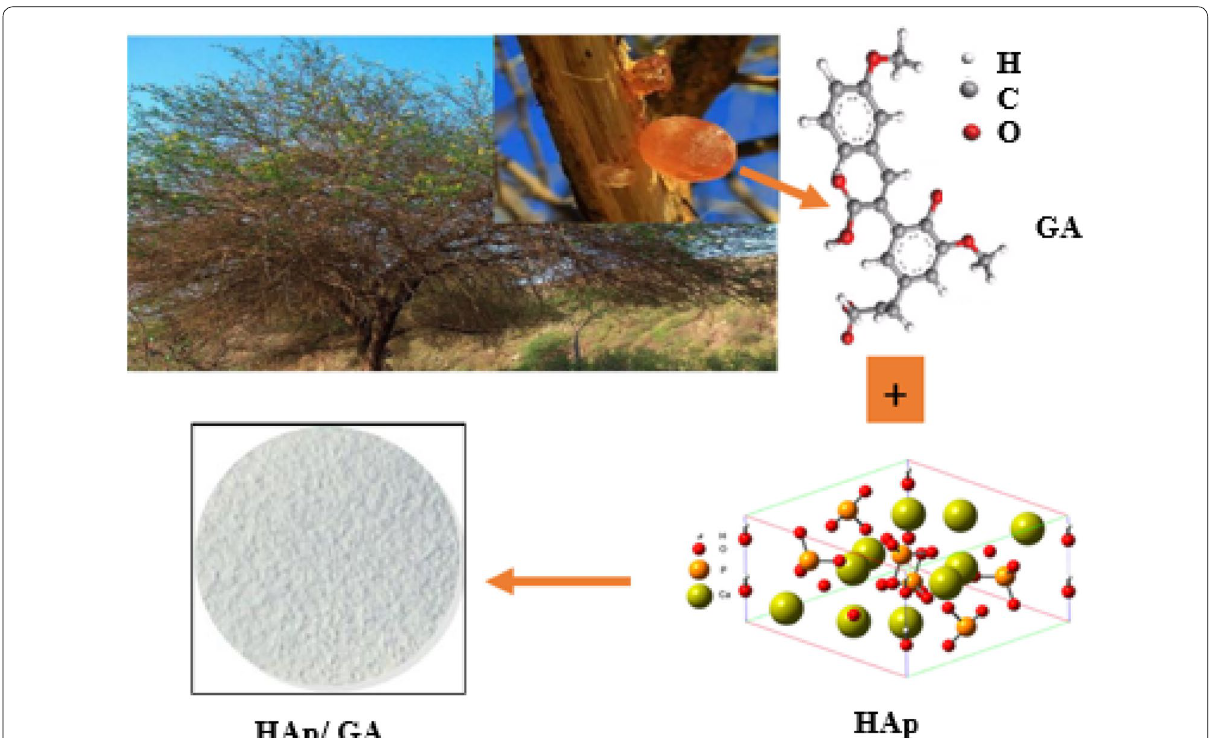
Fig. 1 Schematic representation of synthesis route HAp/GA